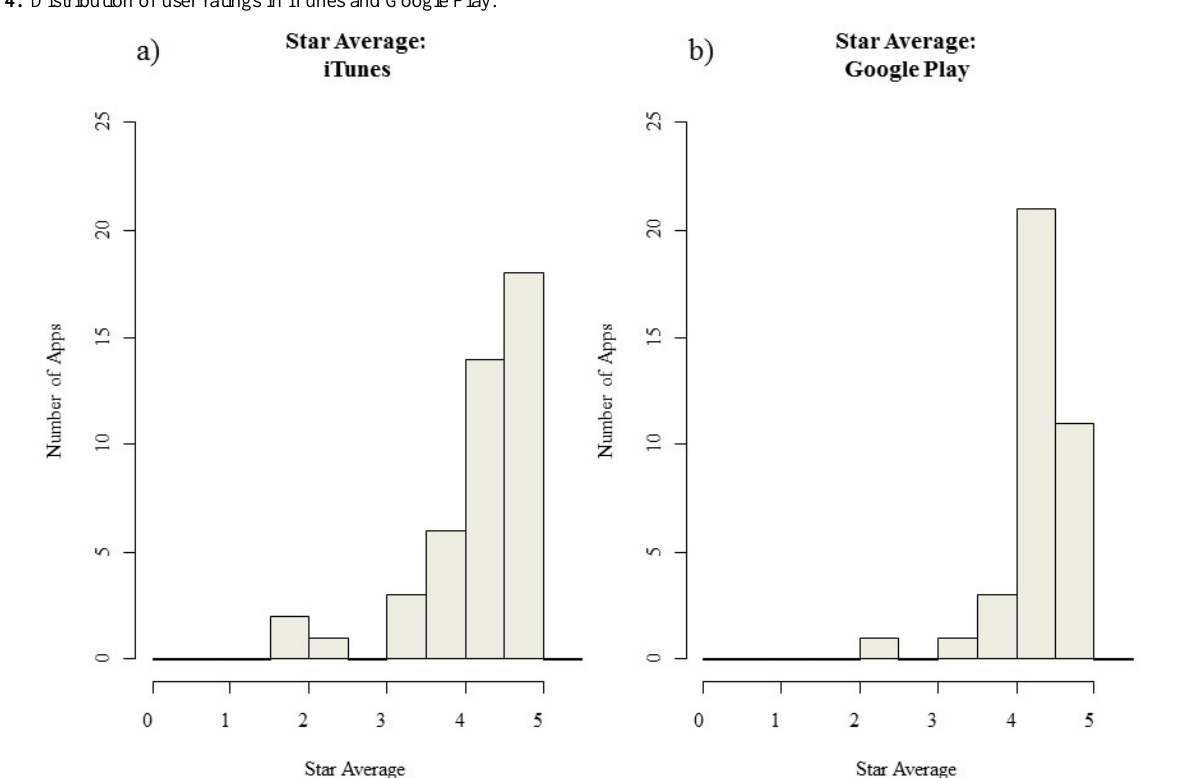
Figure 4. Distribution of user ratings in iTunes and Google Play.